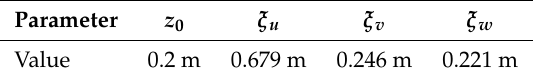
Figure 16. Free-stream PSD length scale profiles: regression vs. LES data. Table 3. Free-stream length scale regression